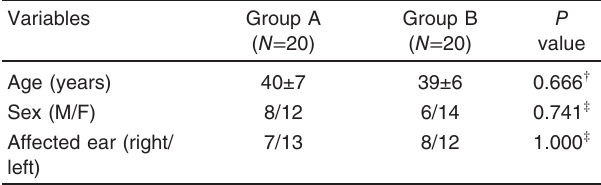
Table 1 Characteristics of patients in either study group Variables